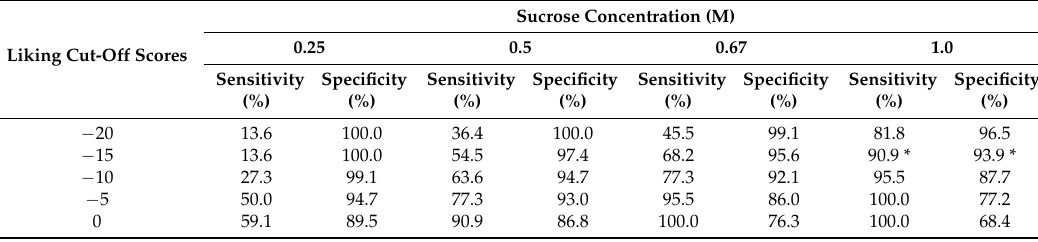
Table 2. Sensitivity and specificity checks to discriminate sweet dislikers (cluster 3) from the rest of sweet taste liker